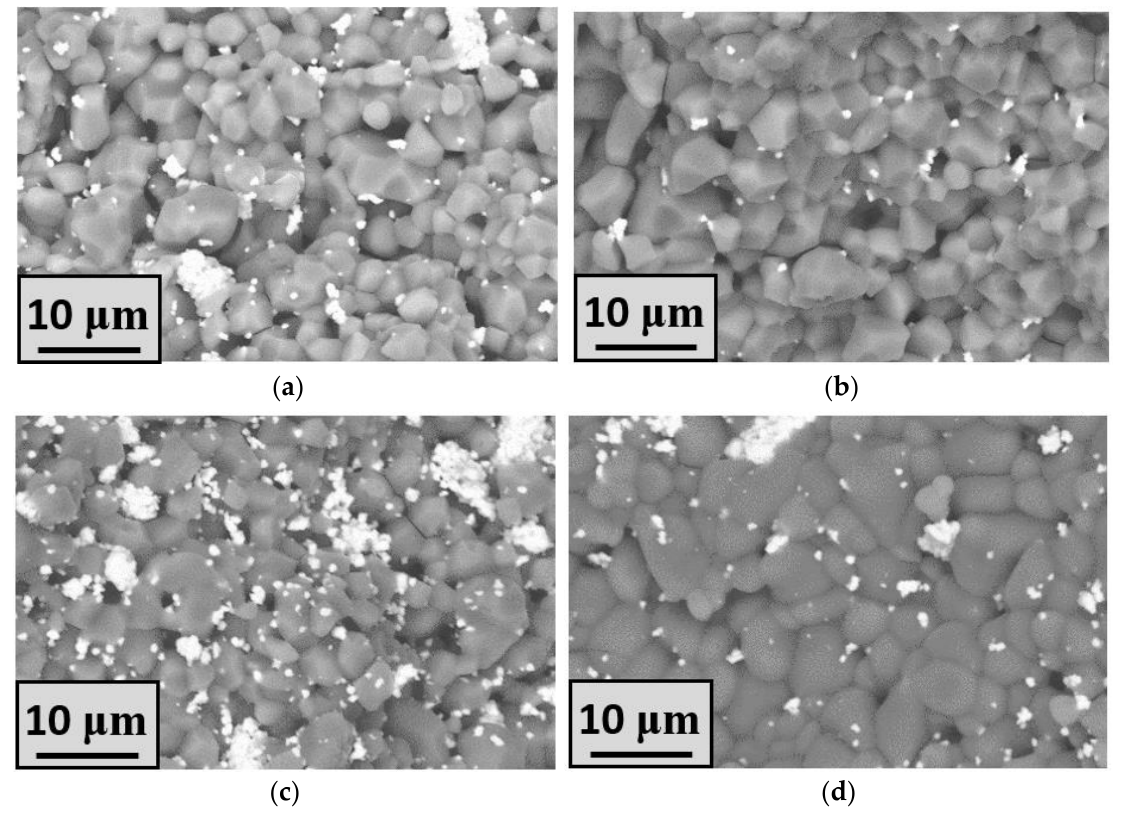
Figure 3. SEM images (QBSD) of the samples: ( a ) Mg5KY-TZP, ( b ) Mg15KY-TZP, ( c ) Mg5NaY-TZP, and ( d ) Mg15NaY-TZP.